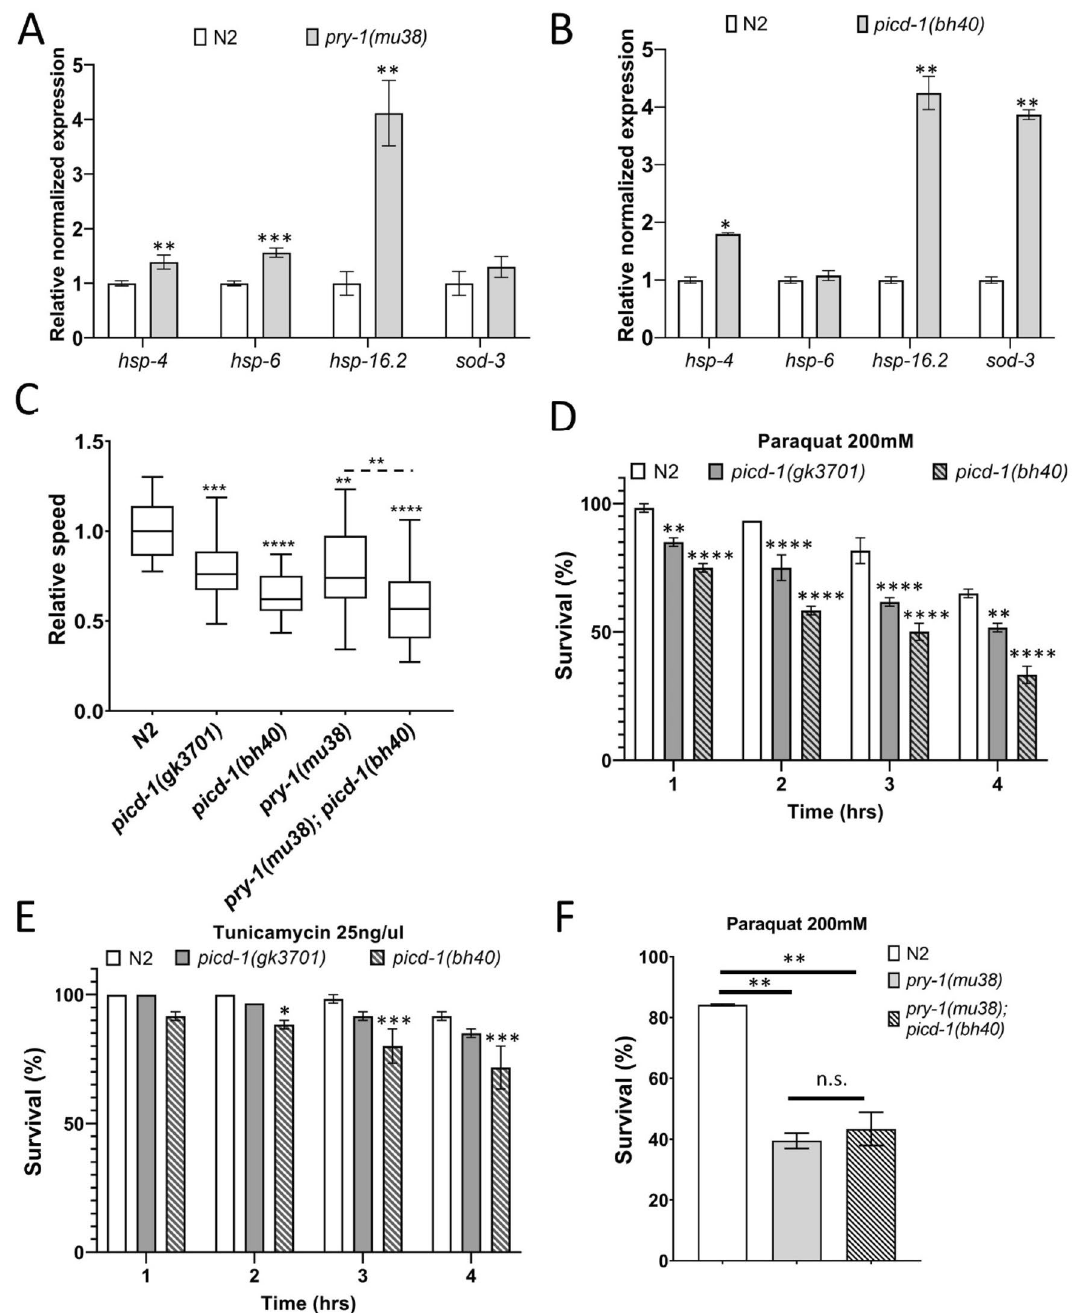
Figure 8. picd-1 mutants are stress sensitive. ( A , B ) Expression levels of hsp-4, hsp-6, hsp-16.2 , and sod-3 in picd-1(bh40) and pry-1(mu38) young adults. Data represent the means of three replicates and error bars represent the standard error of means. p values were calculated using Bio-Rad software (t-test). ( C ) Box and whisker plots represent normalized electrotaxis speeds of picd-1(gk3701) , picd-1(bh40) , pry-1(mu38) and pry- 1(mu38); picd-1(bh40) mutants (n = 20). Measurements show 25 to 75th percentiles of data, central horizontal lines represent medians, and vertical lines extend to 10th and 90th percentiles . ( D ) Bar graphs represent percentage survival following 200 mM paraquat exposure for 4 h (n = 90). ( E ) Bar graphs represent percentage survival of animals following 25 ng/µl tunicamycin exposure for 4 h. ( F ) Bar graphs represent percentage survival of animals following 200 mM paraquat exposure for 2 h (n = 120 for N2, 150 for pry-1(mu38) and 169 for pry-1(mu38); picd-1(bh40) ). For panels ( C – F ), data are the cumulative of two replicates and error bars represent the standard deviation. ( C , F ) Statistical analyses were done using one-way ANOVA with Dunnett’s multiple comparison test. ( D , E ) Statistical analyses were done using two-way ANOVA with Tukey’s multiple comparison test. In all cases significant differences are indicated by stars (*): * ( p < 0.05), ** ( p < 0.01), *** ( p < 0.001), **** ( p < 0.0001). Refer to Table S2 for detailed statistical